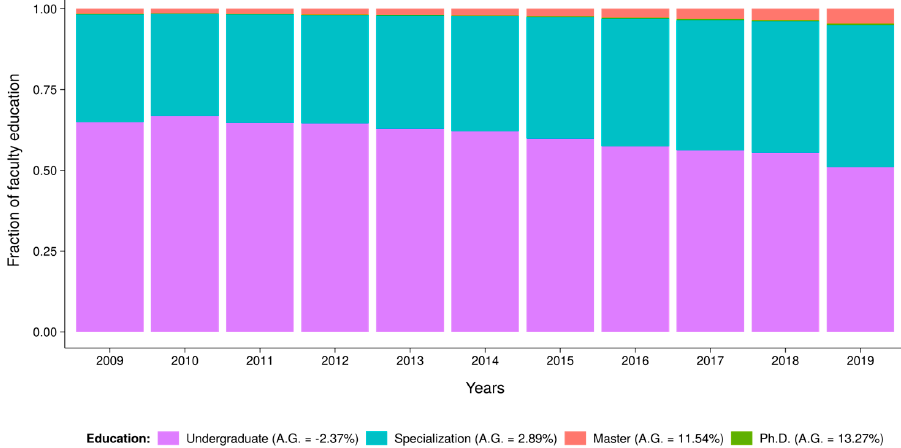
Figure 5. Decision tree.